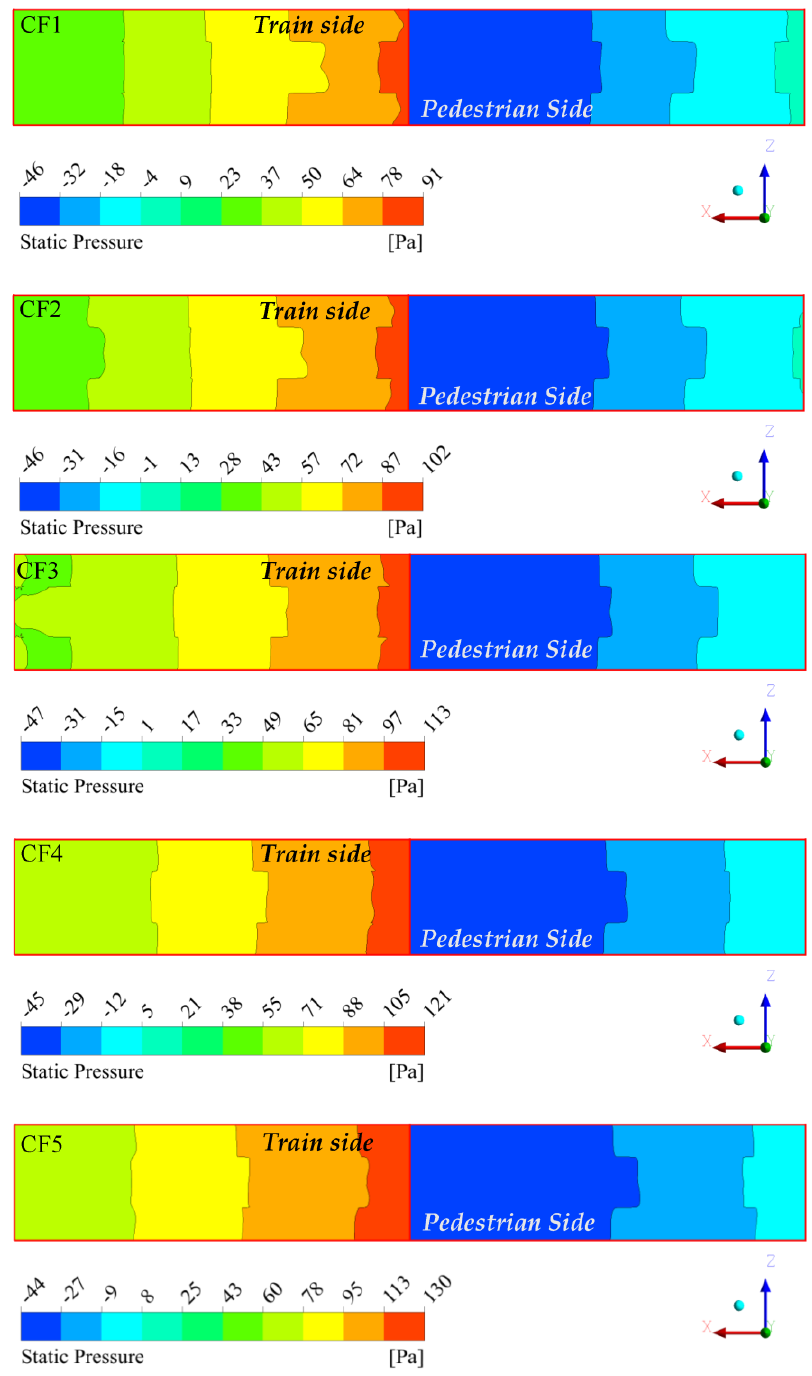
Figure 6. Pressure distributions along streamwise direction under different inflow boundary condi- tions.